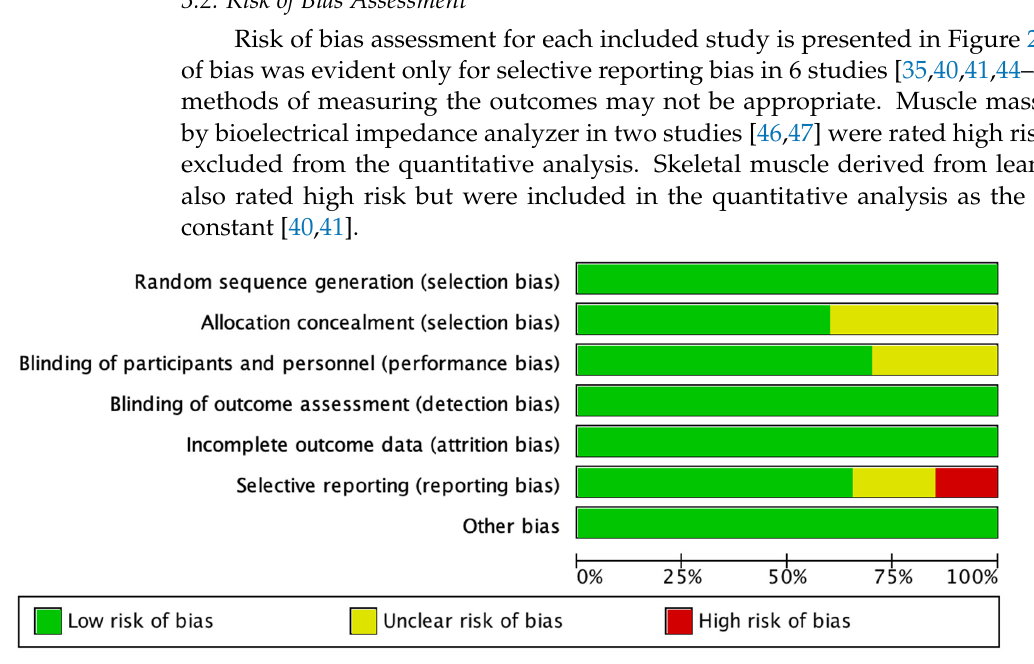
Figure 2. Risk of bias assessment presented as a percentage across all included studies.